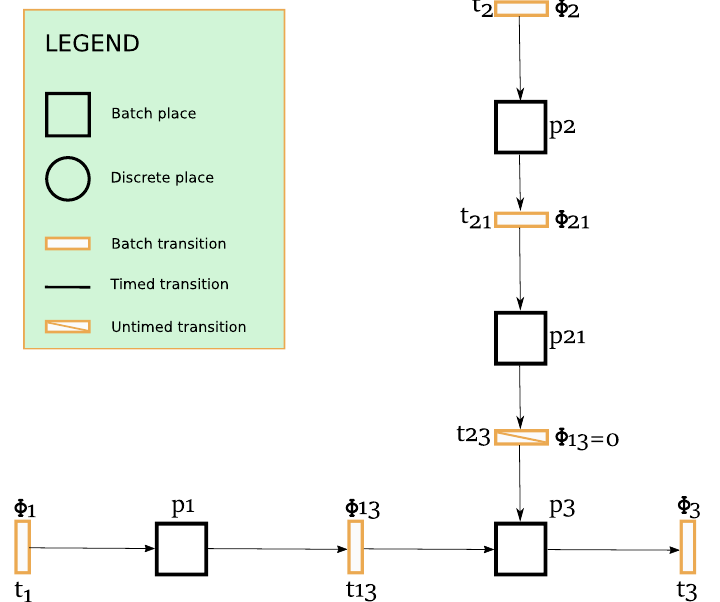
Figure 4. Generalized nondeterministic batch Petri net representation of traffic flow of the use